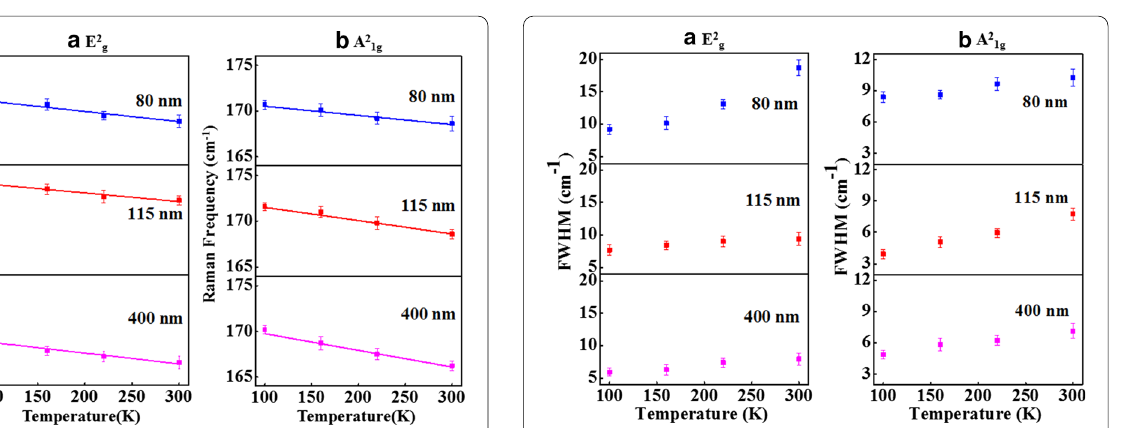
Table 2 The first-order temperature coefficient (χ)